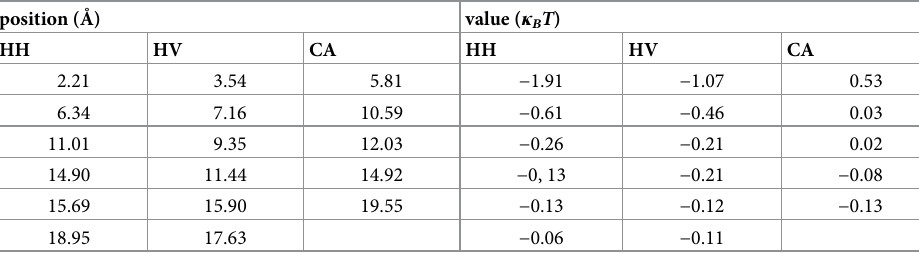
Positions and values of the minima of the average effective statistical potential V � ( R ) for different coarse-graining levels.